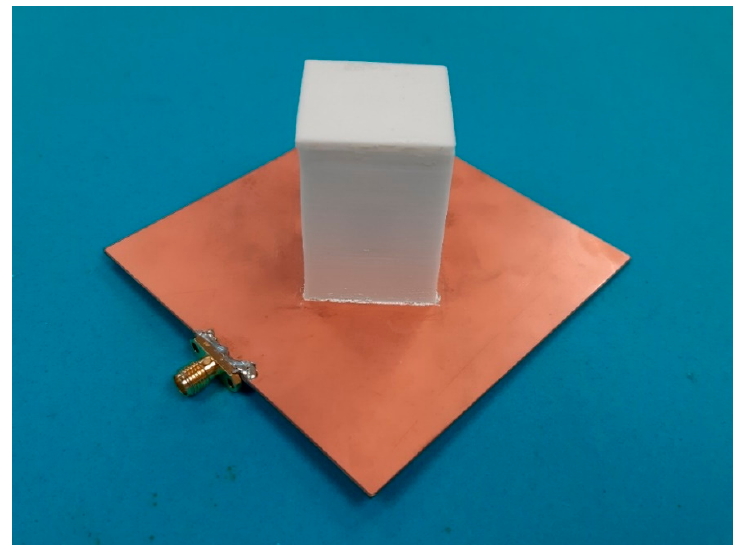
Figure 11. Photograph of the fabricated antenna prototype with the following dimensions: a = 25.6 mm, b = 25 mm, h = 41 mm, w slot = 5.2 mm, l slot,1 = 32.6 mm, l slot,2 = 18.7 mm, l stub = 8.5 mm, l G = w G = 90 mm, and w strip = 2.7 mm. A dielectric constant of 10.14 or 60% BST content was used to construct the antenna.